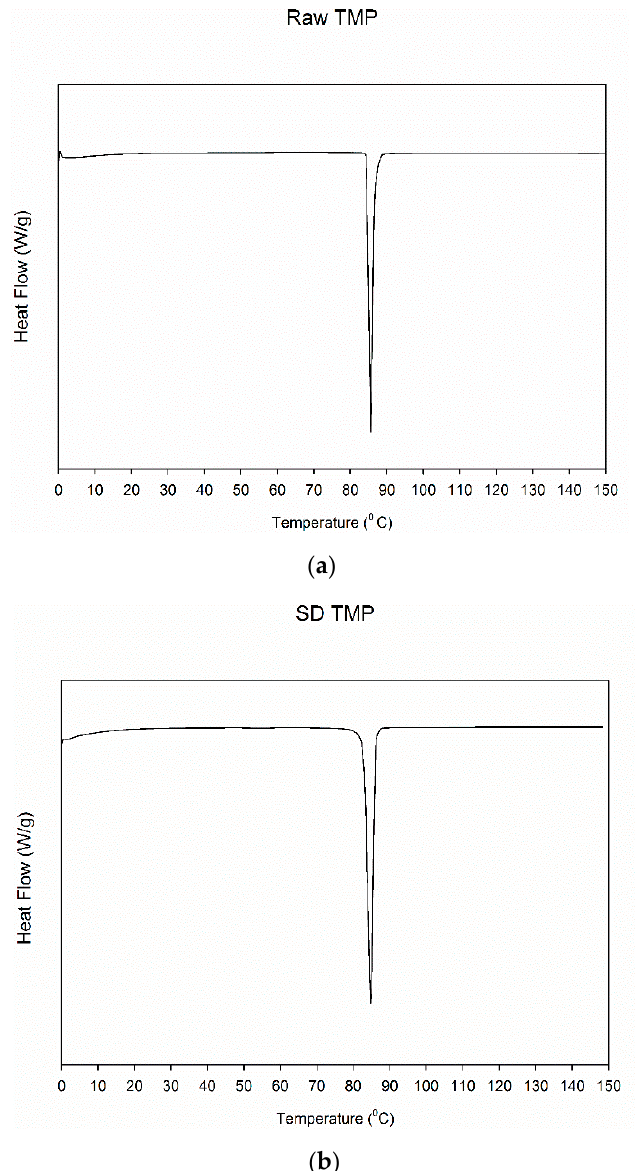
Figure 4. DSC thermograms of: ( a ) Raw TMP and ( b ) SD TMP (Exothermic peak is upward; Endothermic peak is downward).